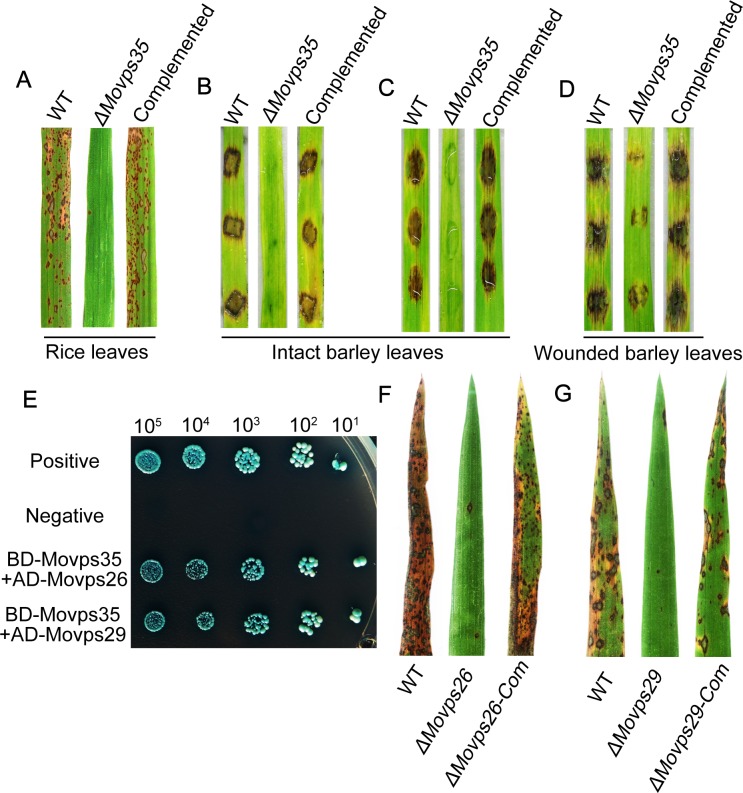
The retromer subcomplex MoVps35-MoVps26-MoVps29 is required for proper pathogenesis in the rice-blast fungus.(A) Pathogenicity assays on rice seedlings. Rice leaves (Oryza sativa cv. CO39) sprayed with conidia from the wild-type strain ΔKu70, ΔMovps35 mutant and the complemented ΔMovps35 strain. (B), (C), (D) are pathogenicity assays on barley leaves. Barley leaves were inoculated with mycelial plugs (B) or with 20 microliter of conidial suspension (ca 105 conidia/mL) (C). (D) Barley infection using wounded/abraded leaves. Lesion formation on leaves was observed 7 days after inoculation with mycelial plugs from the indicated strains. (E) Yeast two-hybrid assay for the interaction between retromer components. (F) and (G) Mutant analysis in MoVPS26 and MoVPS29 suggests a role for cargo-specific retromer in M. oryzae pathogenicity. Conidia from the indicated strains were inoculated on the susceptible rice (CO39) seedlings and imaged 7 days post inoculation.